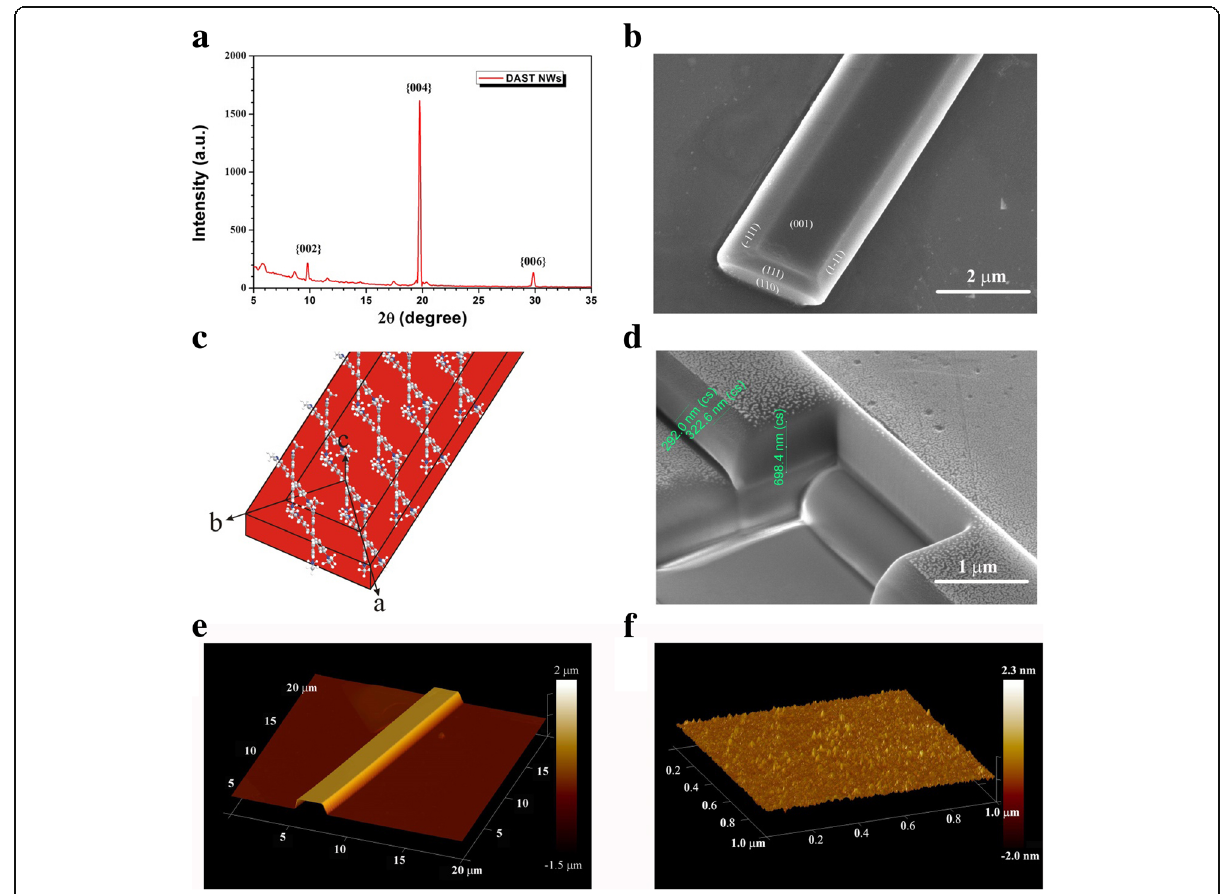
Fig. 2 a The XRD pattern of DAST NWs. b SEM image of a DAST NW from the [001] perspective, where, based on the typical characteristics of bulk crystal growth, the [-111], [111], [1-11], and [110] faces can be identified. c DAST molecular alignment in the NW, where the tosylate anions have been omitted for clarity. d The cross-section of a DAST NW cut by a focused ion beam. e AFM image of a DAST NW. e The surface roughness of a DAST NW, as determined using an